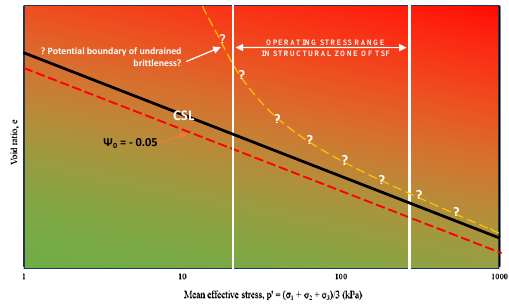
Fig. 7: CSL and critical zones Figure 7. CSL and critical